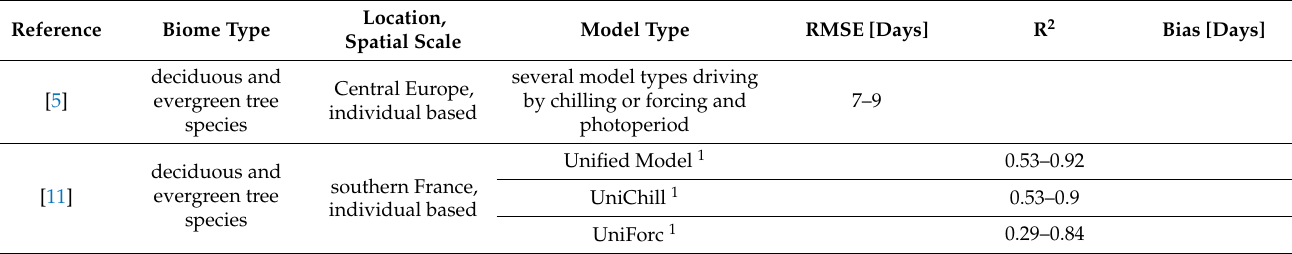
Table 5. Performance metrics of selected spring phenology models and those from this study. Some of the values were estimated from figures presented in respective publications. Data presented for this study are based on Table S3 of the Supplementary